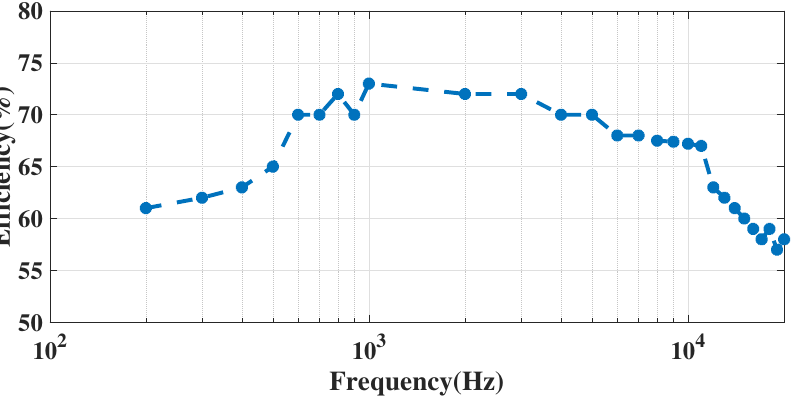
Figure 21. Efficiency versus frequency plot at 20 W